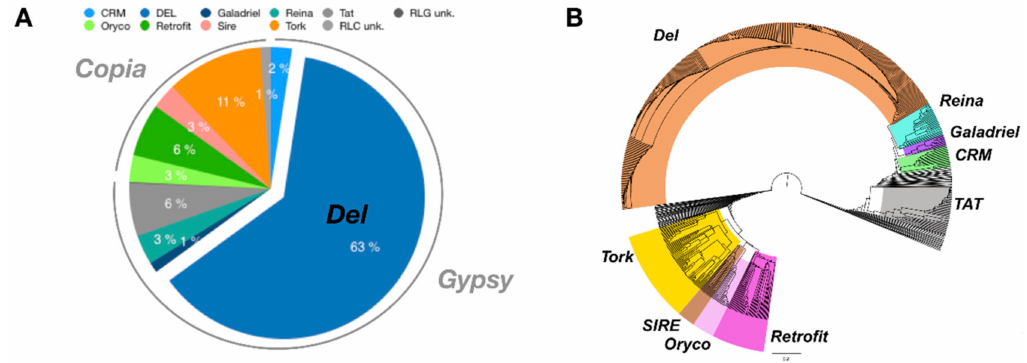
Figure 5. LTR retrotransposon lineages identified in consensus sequences identified by Inpactor. ( A ) Proportion of the different lineages in consensus sequences. The Del lineage represented 64% of all LTR retrotransposon annotated consensus sequences. ( B ) Phylogenetic analysis of annotated LTR retrotransposon consensus